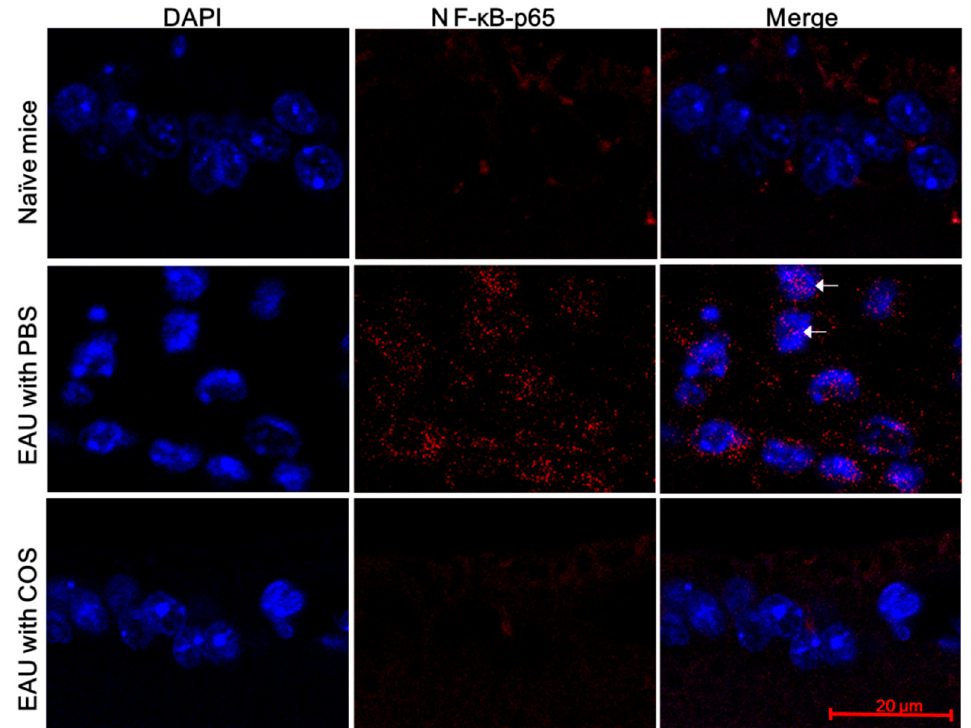
Figure 5. COS treatment reduces the nuclear translocation of NF- κ B subunit p65 in the retinas of mice with EAU induction. Eyes of mice without EAU induction and treatment (naïve) or with EAU induction and treated with PBS or COS (20 mg / kg) were monitored by immunofluorescence staining for NF- κ B (p65) with antibody and nuclei with DAPI. The ganglion cell layer of the retina is shown. Images are representative of > 4 samples per group from two independent experiments. White arrows indicate NF- κ B (p65) in the nucleus.